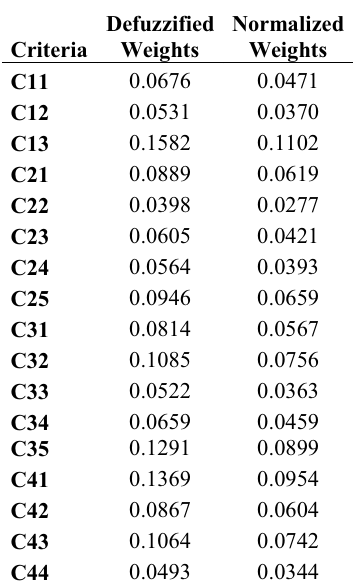
Table 14: The defuzzified and normalized global weights of the